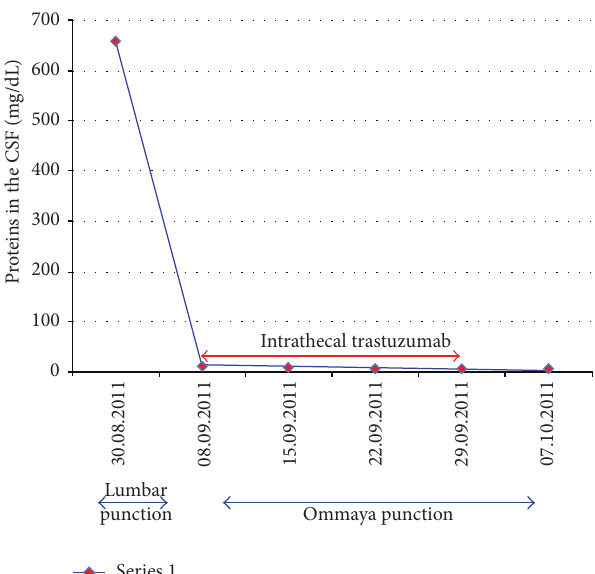
Figure 2: Decreased values until normal ranges of the CSF protein level with IT trastuzumab. First value corresponds to the lumbar punction. The next values corresponds to the Ommaya reservoir functions.